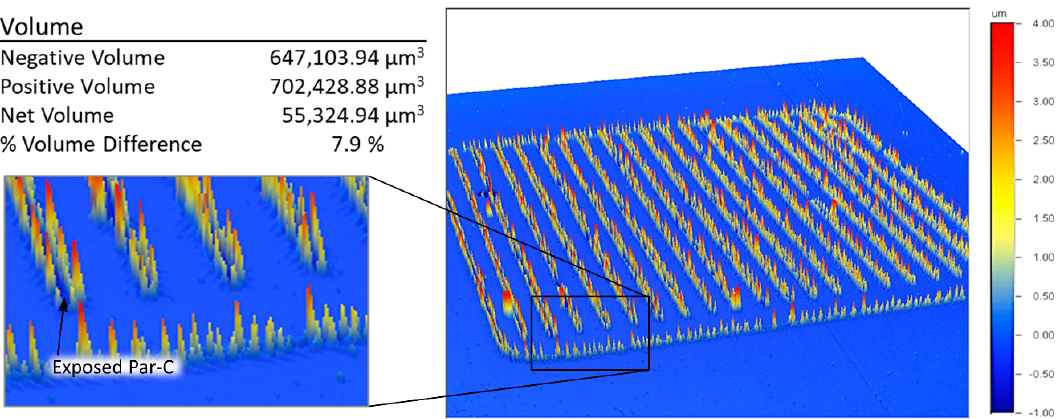
Figure 6. 3D profilometry mapping of an Ag linear array formed by directed dewetting with a spacing of 100 µ m. “Negative” and “Positive” relate to the surface of the original Ni film. The accounting of the displaced volume reveals that 7.9% of the excess positive space remains unaccounted for after the dewetting process.